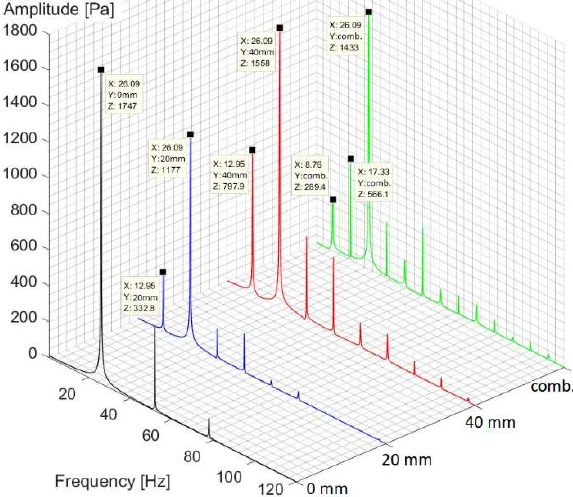
Fig. 11 Amplitude-frequency characteristics calculated from point 5 for static pressure (at 50% height of turbine chamber)